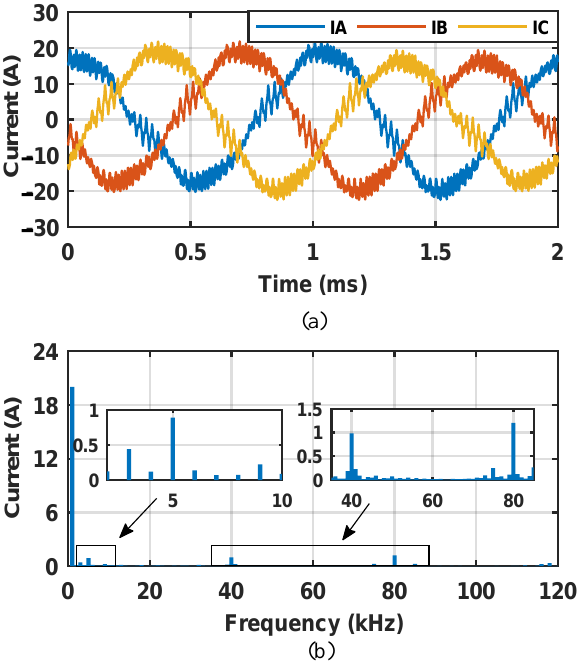
Figure 16. The current of the SVPWM algorithm with OVDT of 1-norm. ( a ) The three-phase current. ( b ) The harmonic of the